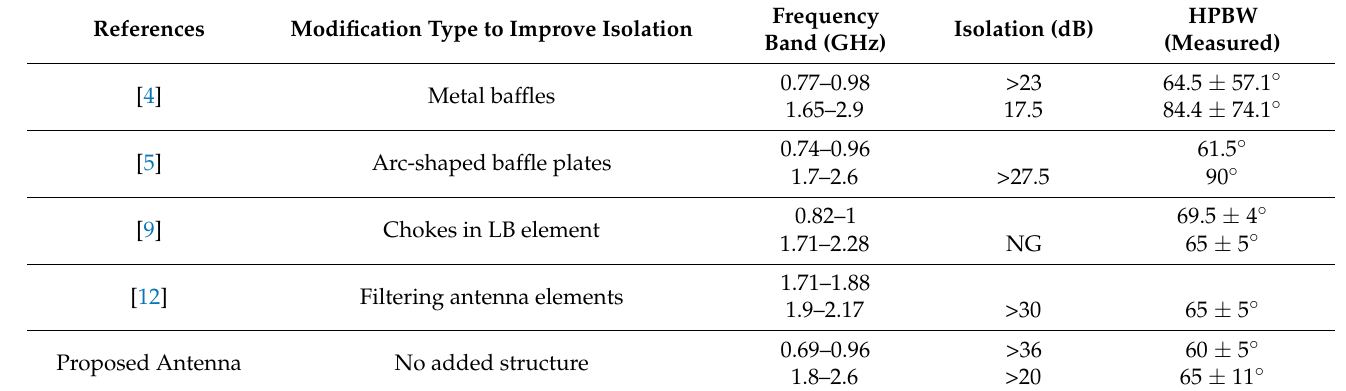
Table 2. Comparison of recent state-of-the-art works with proposed work.